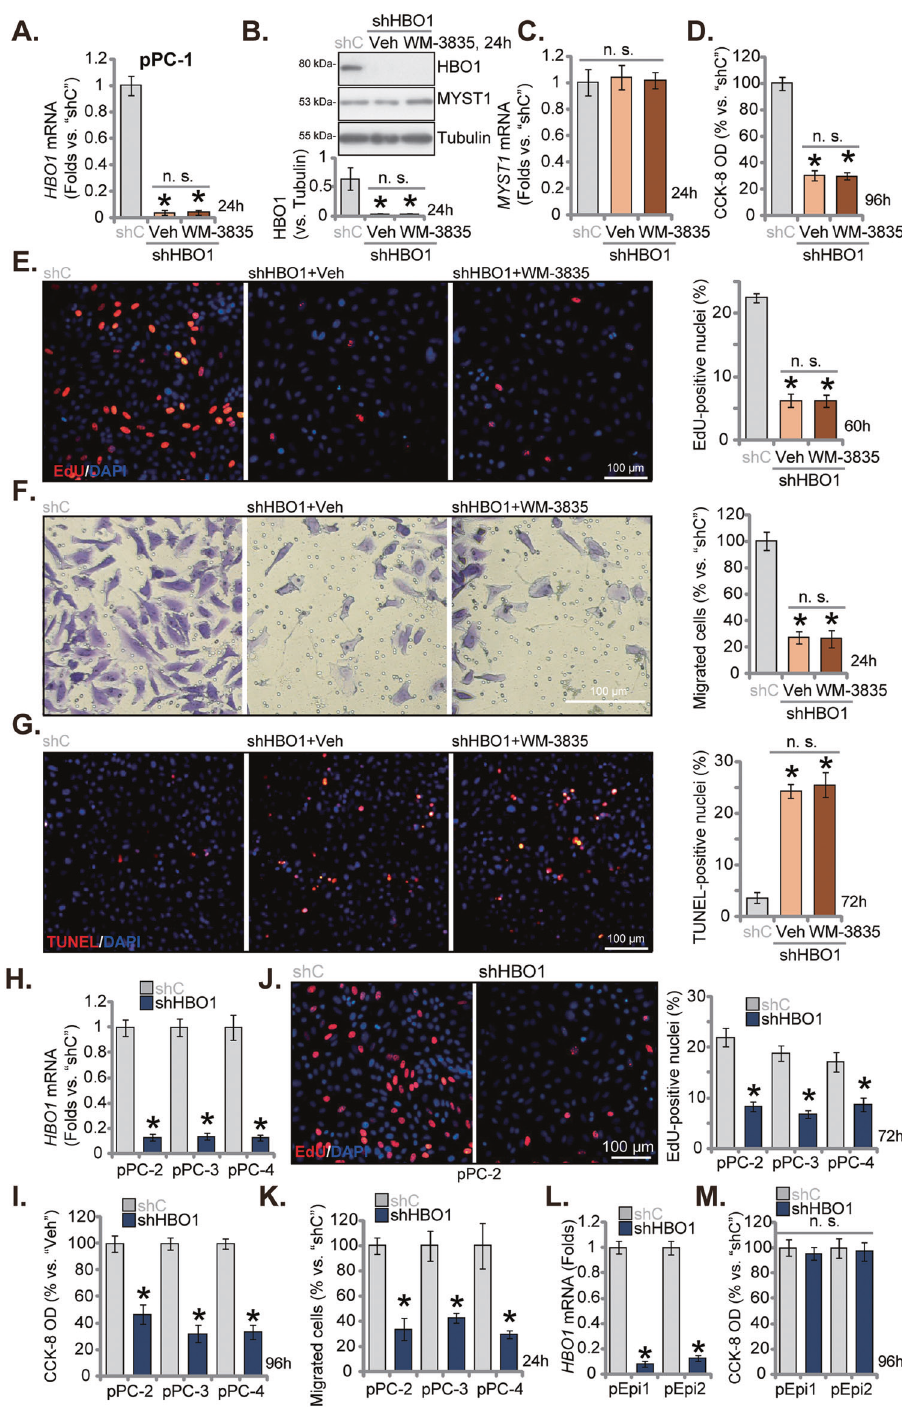
Fig. 3 HBO1 silencing inhibits primary CRPC cell viability, proliferation and migration in vitro. The primary pPC-1 cells were infected with the HBO1-shRNA-expressing lentivirus ( “ shHBO1 ” ) or the scramble control shRNA-expressing lentivirus ( “ shC ” ), and stable cells were formed after selection and veri fi cation. The shHBO1 pPC-1 cells were further treated with WM-3835 (10 μ M) or vehicle control ( “ Veh ” ) for designated hours, expression of listed mRNAs and proteins was measured ( A – C ); Cell viability, proliferation, in vitro migration and apoptosis were tested by CCK-8 ( D ), the nuclear EdU incorporation staining ( E ), “ Transwell ” ( F ) and nuclear TUNEL staining ( G ) assays, respectively. The primary human prostate cancer cells derived from three other CRPC patients, pPC-2/pPC-3/pPC-4 ( H – K ), or the primary human prostate epithelial cells ( “ pEpi1 ” and “ pEpi2 ” , derived from two patients) ( L , M ), were stably transduced with shHBO1 or shC, HBO1 mRNA expression was measured ( H , L ); After culturing for indicated time periods, cell viability ( I , M ), cell proliferation ( J ) and in vitro cell migration ( K ) were measured similarly. Data were expressed as the mean ± standard deviation (SD, n = 5). * P <0.05 versus “ shC ” group. “ n. s. ” stands for non-statistical difference ( P >0.05). Scale bar = 100 μ m.